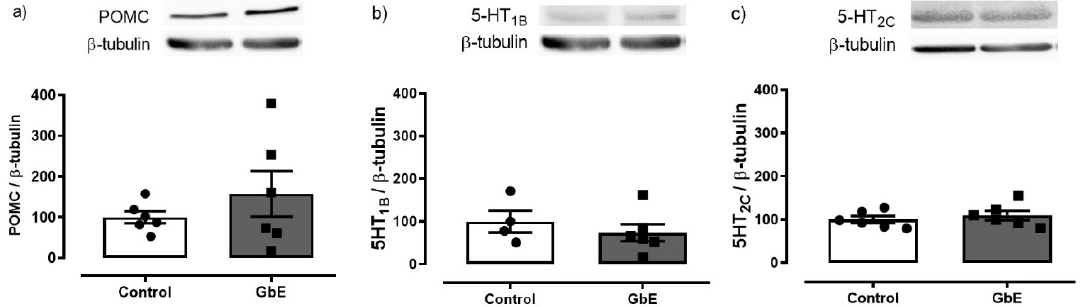
Figure 4. Hypothalamic protein expression. POMC ( a ), 5-HT1B ( b ), and 5-HT2C ( c ) of control ( n = 4–6) and Ginkgo biloba (GbE; n = 6) groups.